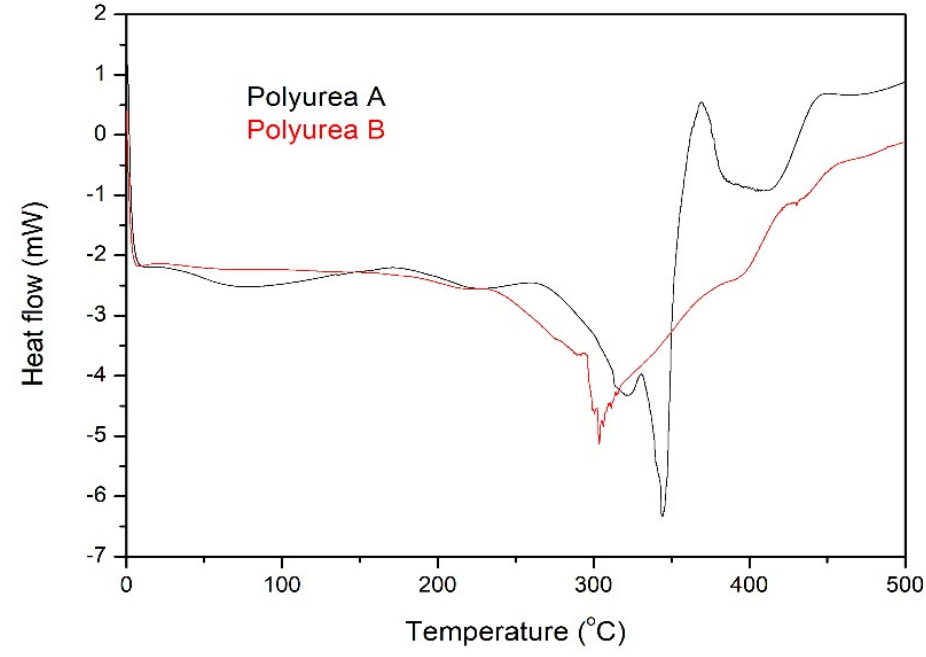
Figure 3. DSC plot of polyureas A and B.